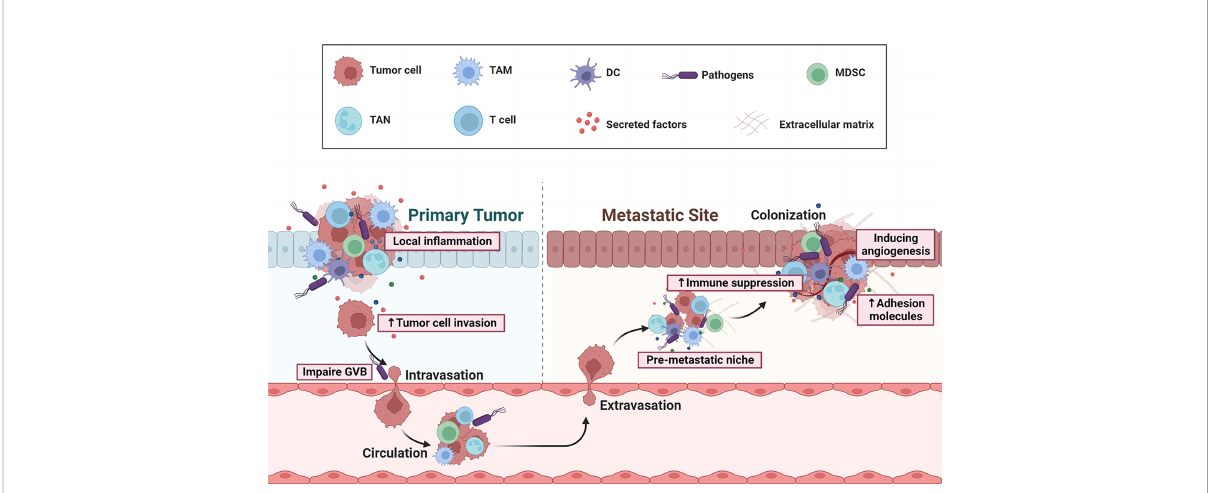
FIGURE 2 Overview of gut microbial dysbiosis on CRC initiation and metastasis. Dysbiosis can cause a chronic, pro-in fl ammatory milieu, by eliciting secretion of a repertoire of cytokines or growth factors, and thereby facilitates tumor cell invasion, adhesion, extravasation and survival. Some pathogens (eg: Escherichia coli ) can induce gut vascular barrier (GVB) disruption, which allows bacteria to reach the distant organ and initiate the recruitment of immune cells with immunosuppressive functions, such as MDSCs and Tregs. Thus, the microbiota can contribute to the immune escape of distant tumors, the pre-metastatic niche maturation, adhesion, angiogenesis, and eventually the formation of